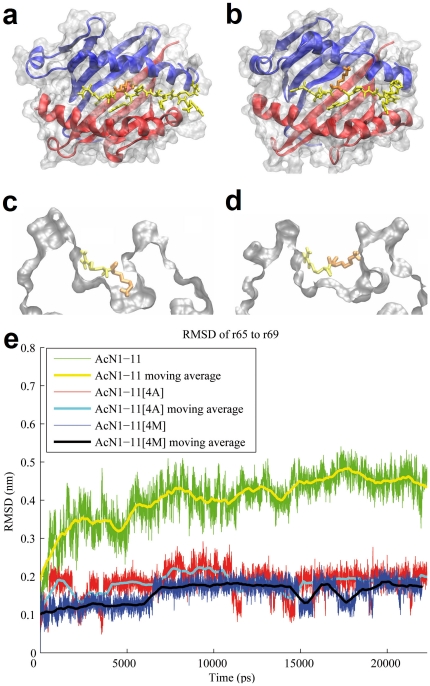
Deformation of r65-69α of the MHC.(a) Top view onto the modeled MBP AcN1-11 : I-Au complex. The MHC α-chain (blue), and the MHC β-chain (red) are represented as a cartoon. The peptide (yellow), represented in licorice style, is bound to the MHC at the peptide binding groove. The lysine at position 4 (orange) is buried in MHC pocket 6. (b) Average structure during simulation from time t = 15 ns to t = 22 ns. The lysine at position 4 left the groove and is bound to the lateral helix of the MHC α-chain, causing a disruption of the helical structure next to position 4 and a widening of the groove at the N-terminal half (i.e. the left side of the picture). (c) Thin cross-section through the MHC pocket 6 of the modeled complex. (d) Same as C but for the average structure during simulation from time t = 15 ns to t = 22 ns. (e) Moving average RMSD of residues 65–69 of the α1-helix of the MHC. Ac1-11 causes the largest deformation in this area of the α1-helix compared to Ac1-11[4A] and Ac1-11[4M]. The moving average is calculated using the neighboring 1000 frames (500 on the left and 500 on the right).